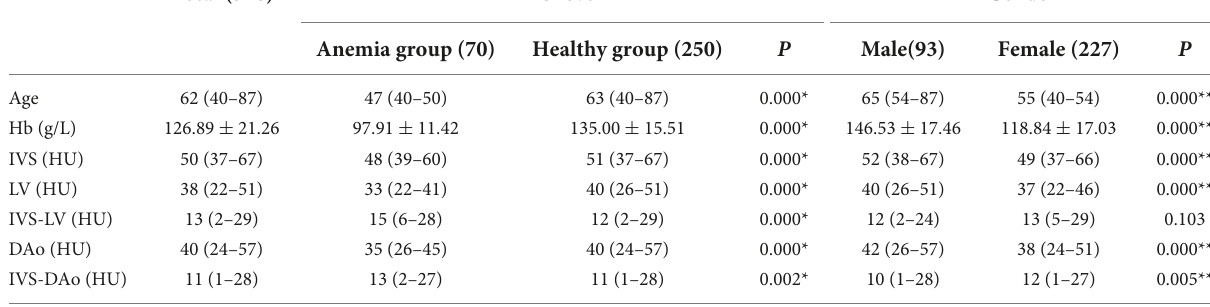
TABLE 4 Descriptive analysis of baseline characteristics in LDCT group.